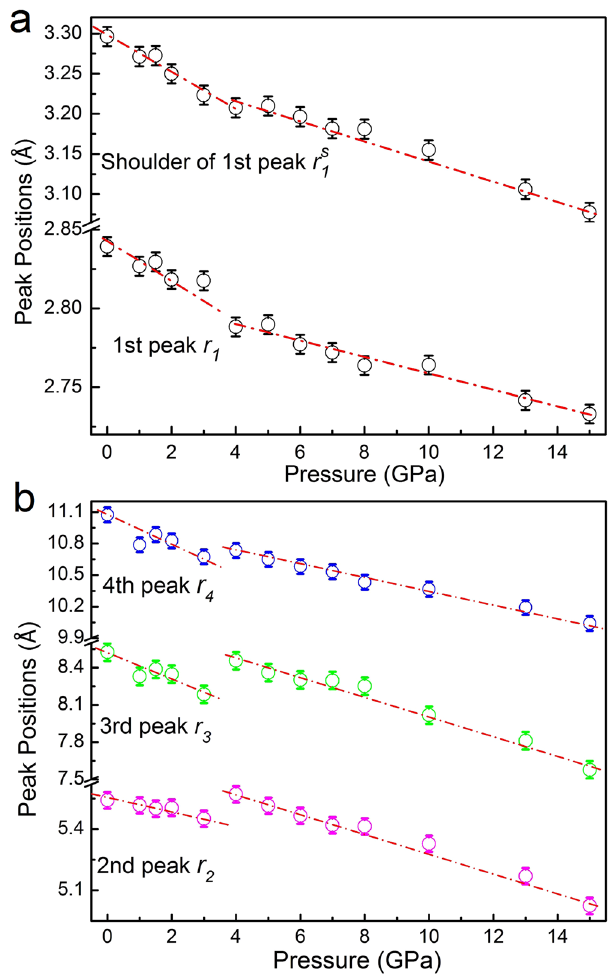
Figure 6. The first four peak positions of g ( r ) obtained from AIMD upon compression for the Ga 86 In 14 eutectic alloy.